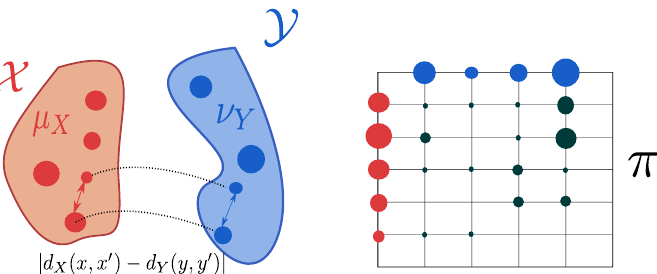
Figure 6. Gromov–Wasserstein coupling of two mm-spaces X = ( X , d X , µ X ) and Y = ( Y , d Y , ν Y ) . Left : the mm-spaces have nothing in common. Similarity between pairwise distances is measured by | d X ( x , x (cid:48) ) − d Y ( y , y (cid:48) ) | . Right : an admissible coupling of µ X and ν Y . Image adapted from [21] [Figure